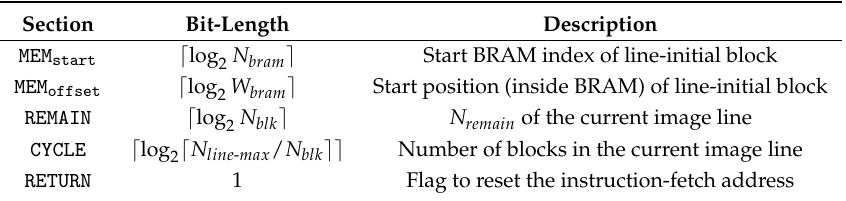
Table 2. Sections of the customized instruction for D-SWIM architecture.